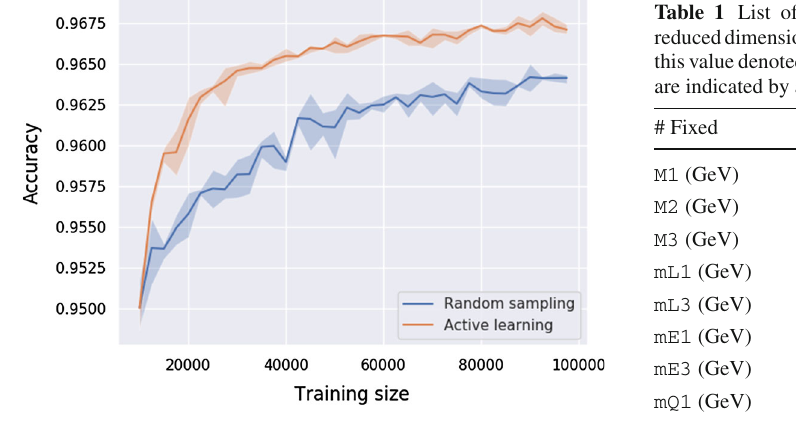
Fig. 5 Accuracy development on model exclusion of the 19- dimensional model for new physics (pMSSM) for random sampling and active learning using a dropout Neural Network with infinite pool. True labeling was provided by a machine learning algorithm trained on model points and labels provided by ATLAS [1]. The gain of active learning with respect to random sampling (as described by Eq. 2) is 3–4. The bands show the range in which all curves of that colour lay when the experiment was repeated 7 times